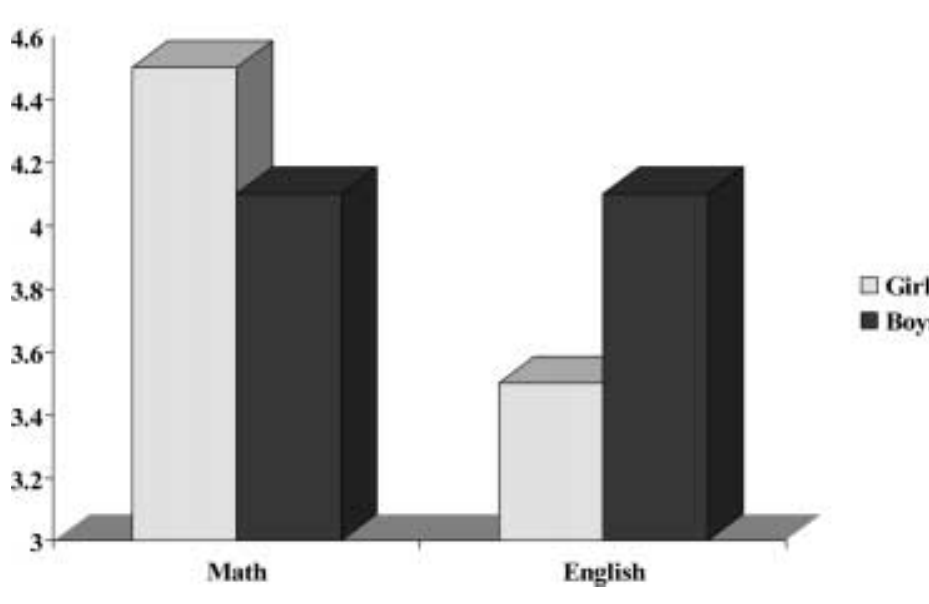
Figure 4. Parents’ rating of adolescent child’s effort in math and